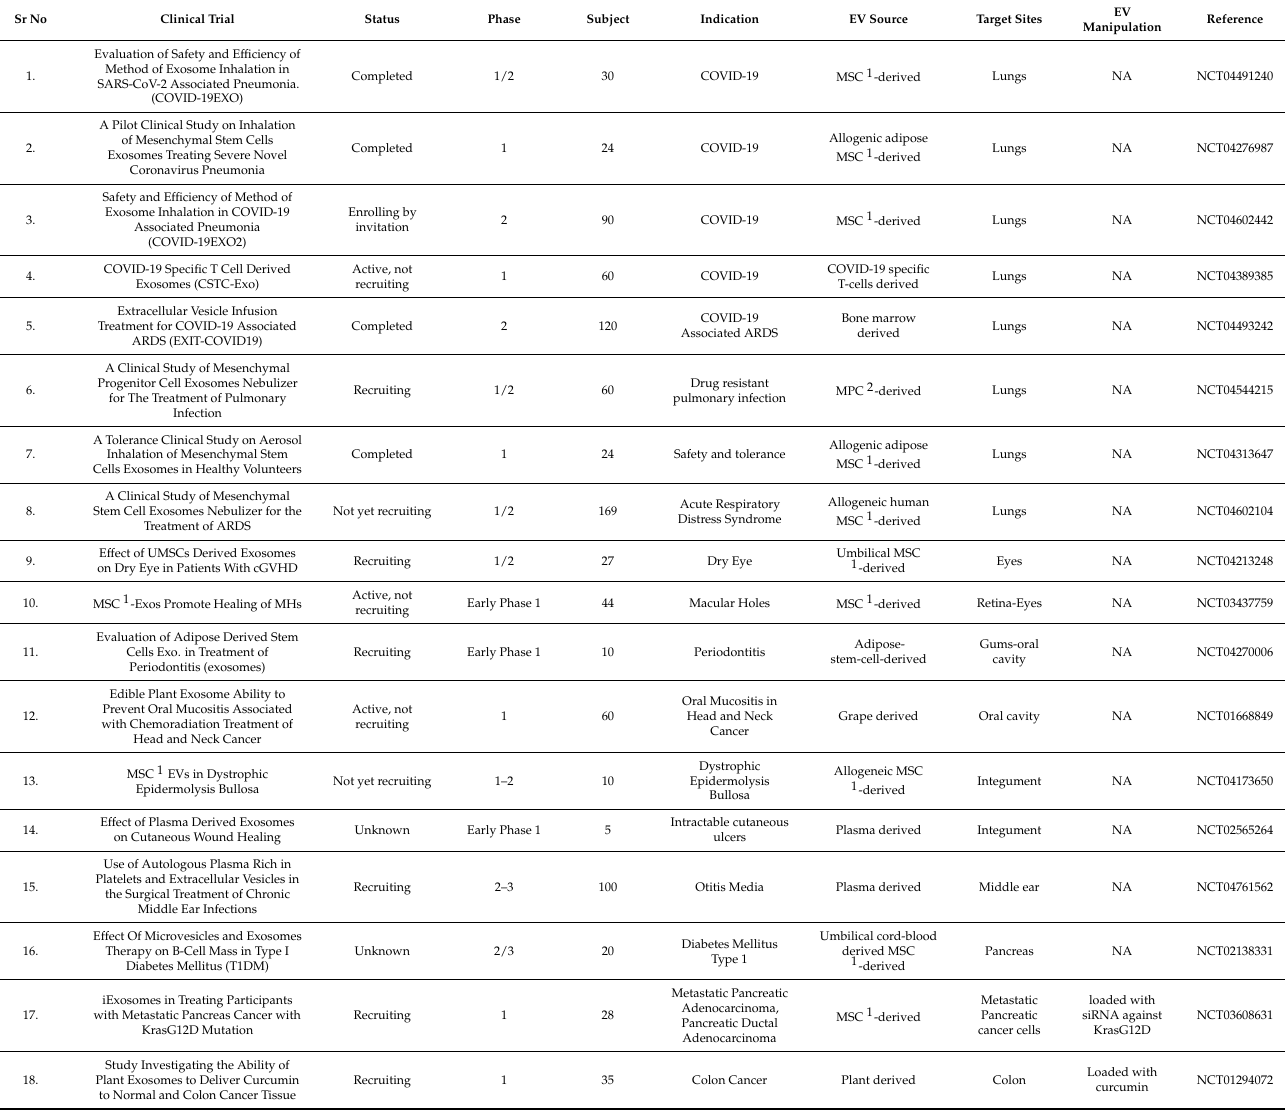
Table 1. Clinical trials evaluating peripherally targeted EV-based